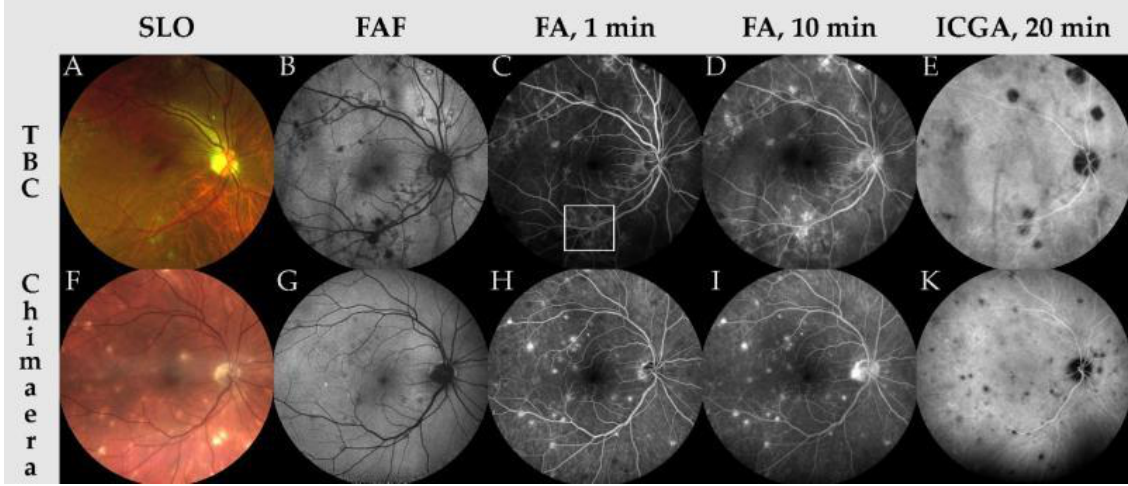
Figure 2 Multimodal imaging findings of patients suffering from multifocal choroiditis due to M. tuberculosis (TBC , A – E) Figure 3. Typical imaging findings of ocular tuberculosis. Late stage fluoresceine angiography (FA; A ) and optical coherence and M. chimaera (F – K). In both scanning laser ophthalmoscopy images (SLO, A , F ) choroidal granulomas can be observed. tomography (OCT; B1 –near infrared fundus image; B2 –OCT- B scan) of a 60-year-old female patient’s left eye illustrating Note that panel A was acquired using an OPTOS device (OPTOS inc., Marlborough, MA, USA) using a green and red a hot disc and macular leakage in FA which corresponds to a cystoid macular edema with sub- and intraretinal fluid in laser, while panel F was acquired using a ZEISS Clarus device (Carl Zeiss Meditec, Inc., Dublin, CA, USA) with red, green the OCT images. OPTOS false-color scanning laser ophthalmoscopy (SLO; C1 , C3 ) and FA ( C2 , C4 ) of a 46-year-old female and blue lasers, hence the difference in false color scheme. Fundus autofluorescence imaging (FAF, B , G ) shows hypoau- patient. In the SLO color image of the right eye, optic disc edema, and multiple non-continuous choroidal granulomas tofluorescence at the location of choroidal granulomas, indicating loss of retinal pigment epithelium. In fluorescein angi- are visible, the vitreous seems to be inflamed in the right eye. In the FA of the right eye ( C2 ), a hot disc, vascular wall ography imaging at 1 min and 10 min (FA, C , D , H , I ) early hypofluorescence in active lesions (panel C, inside white frame) hyperfluorescence and staining of choroidal granulomas can be observed. However, there are no signs of vascular occlusion. The left eye shows no sign of infection ( C3 , C4